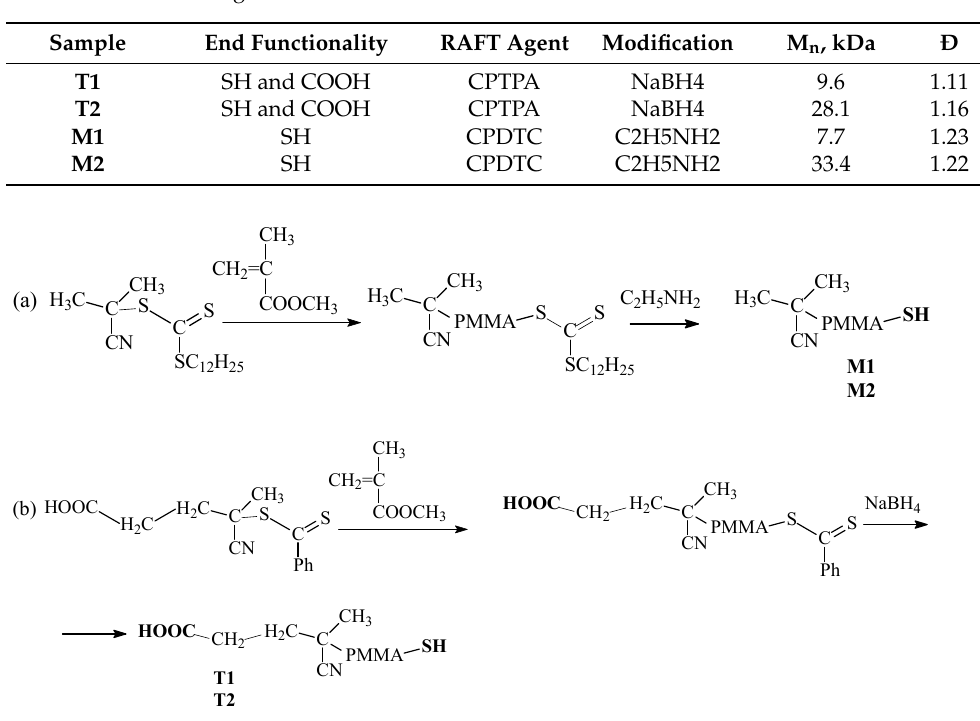
Table 3. Molecular weight characteristics of mono- and telechelic PMMA.